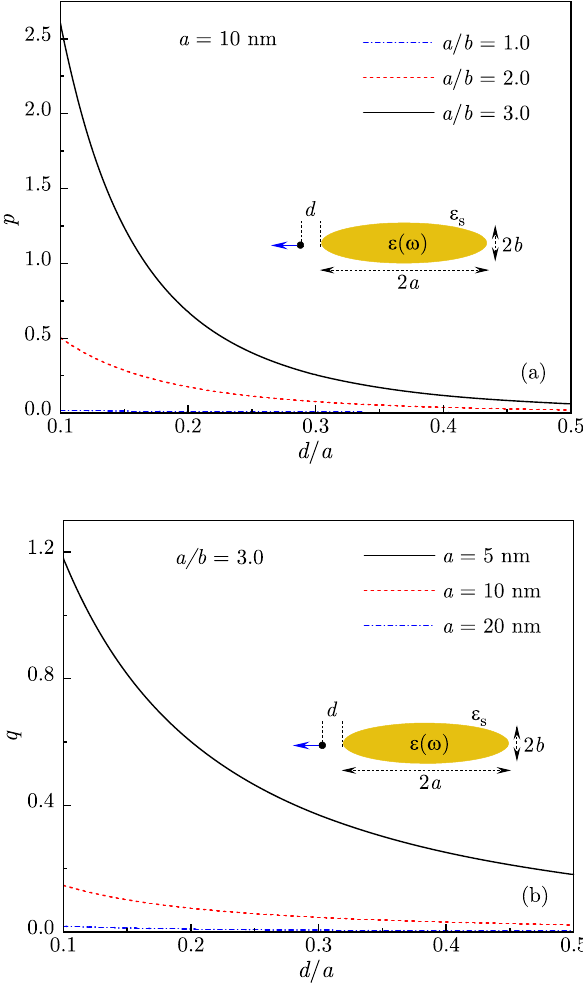
Figure 1: (a) The ExIT parameter p is plotted against the QE distance d to the tip of Au nanorod of length 2 a = 20 nm placed for different values of aspect ratio a ∕ b = 1 . 0, 2.0, and 3.0. (b) The Fano parameter q is plotted against the distance d at nanorod aspect ratio a ∕ b = 3 . 0 for different values of nanorod length 2 a = 40, 20, and 10 nm. Inset: schematics of a QE situated at a distance d from the tip of Au nanorod in water for QE dipole moment oriented along the nanorod